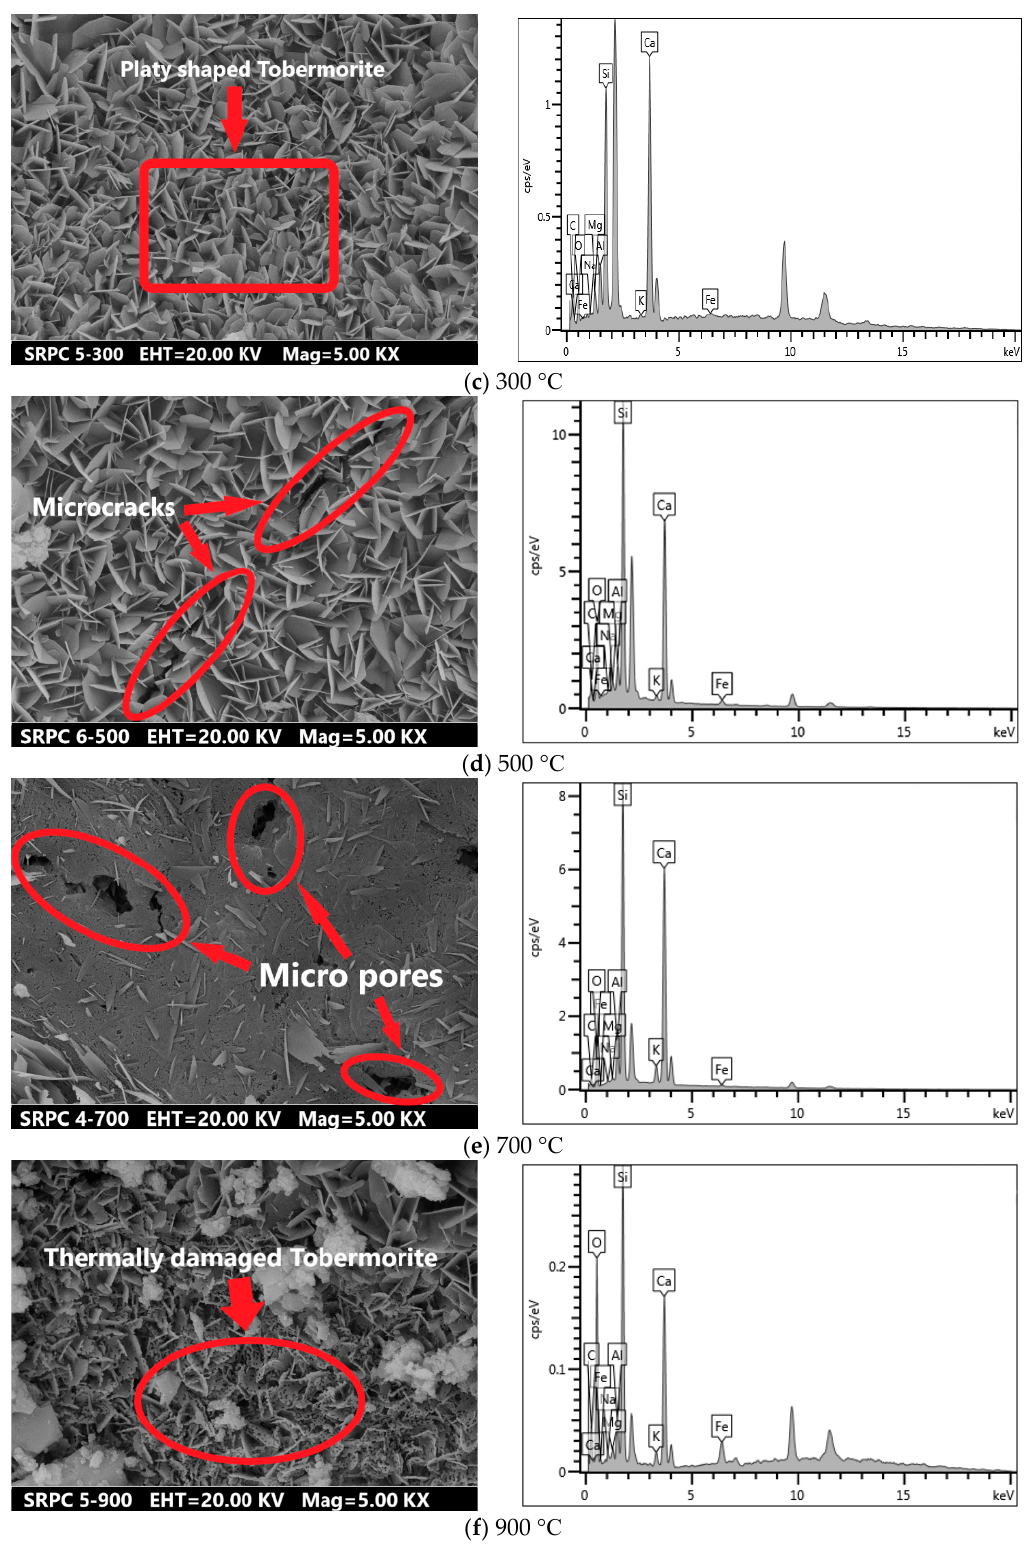
Figure 22. SEM micrographs of secondary hydrates and energy dispersive X ‐ ray spectroscopy (EDX) analysis of RPC matrix at different target temperatures.